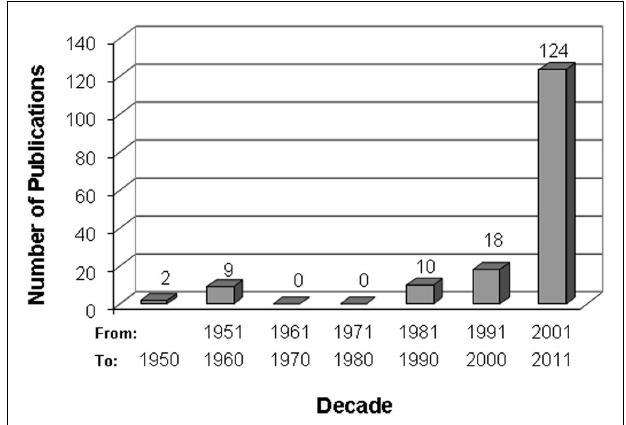
FIGURE 1 | Chronological trend of scientific publications on M. oleifera . The bibliographic search was conducted online in the PubMed database at www.pubmed.ncbi.nlm.nih.org/, using moringa, drumstick, or malunggay as title keywords. Article abstracts were reviewed for content and those unrelated to M. oleifera were discarded. Of the 163 PubMed articles retained, 64 (39.3%) were about the physiological effects of M. oleifera preparation in experimental animals, 30 (18.4%) on their water-cleansing properties as toxic metal absorbent or flocculent, 23 (14.1%) about their chemical composition, 22 (13.5%) about their antimicrobial efficacy, 5 (3.1%) about their antioxidant properties in vitro , 5 (3.1%) about their effects on cellular physiology ex vivo , 6 (3.1%) on their nutritional values, 3 (1.8%) about their therapeutic effects in humans, and 6 about various matters (review, genetics, biofuel, animal